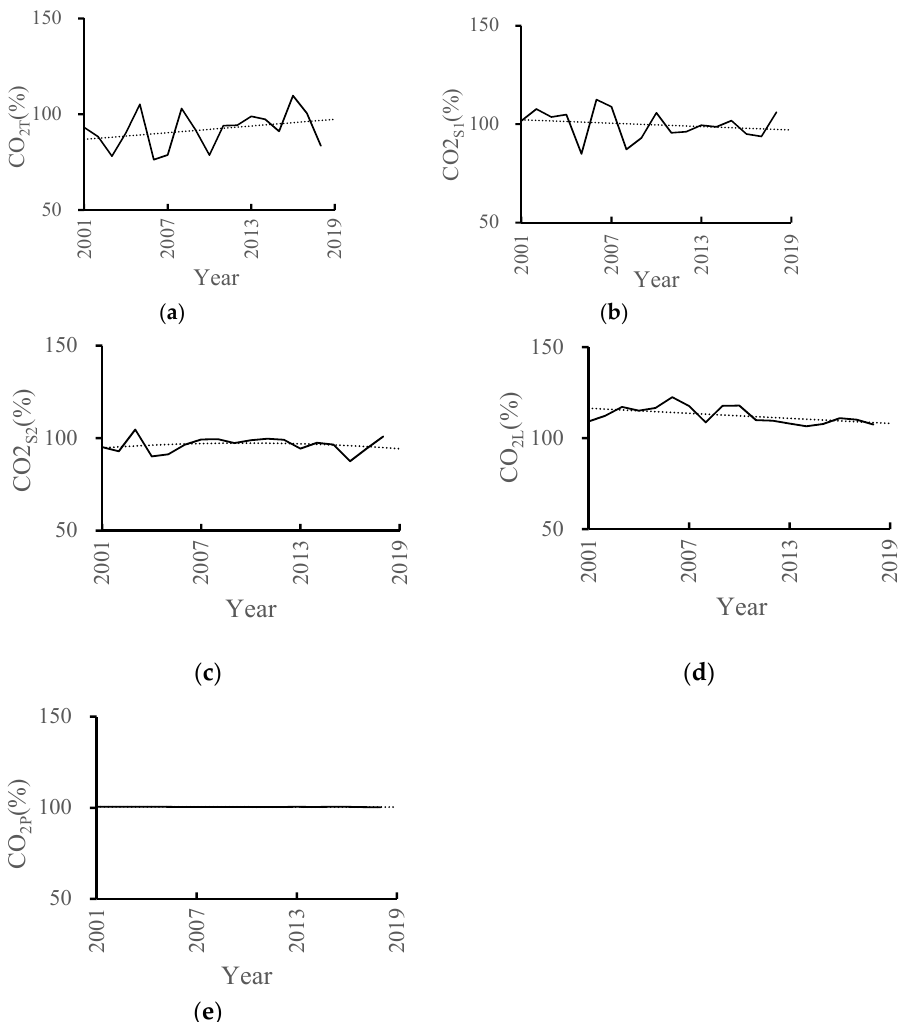
Figure 2. ( a ) Change in the contribution rate of technological advancement effects. ( b ) Change in the contribution rate of effects of agricultural structural change. ( c ) Change in the contribution rate of effects of total economic structural change. ( d ) Change in the contribution rate of living standard improvement effects. ( e ) Change in the contribution rate of population growth effects.